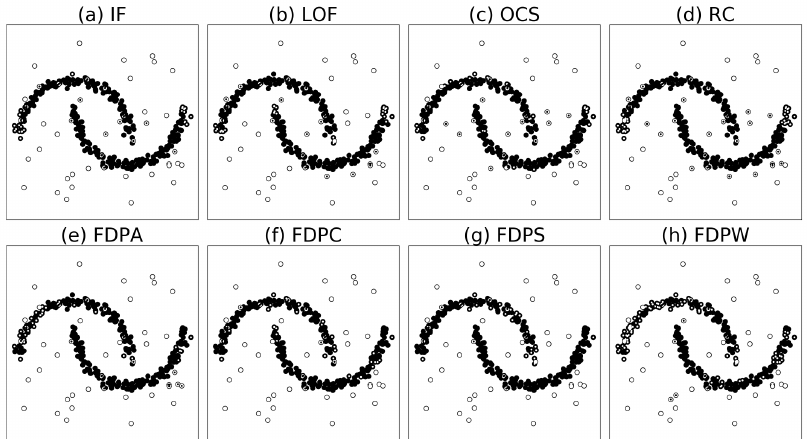
Figure 6. Outlier detection results of the algorithms on synthetic dataset D2. Outliers correct recognized are white points, insiders correct recognized are black points, outliers error recognized are white points with black core, and insiders error recognized are black points with white